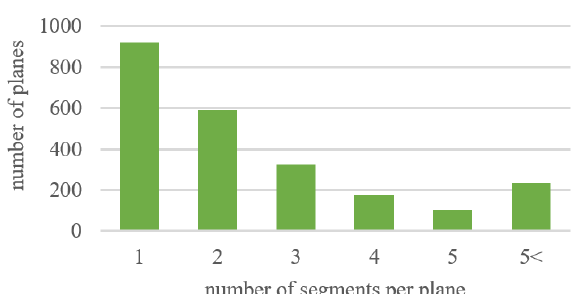
Figure 3. Graph showing the relation between the number of planes and segments in the point cloud per plane.